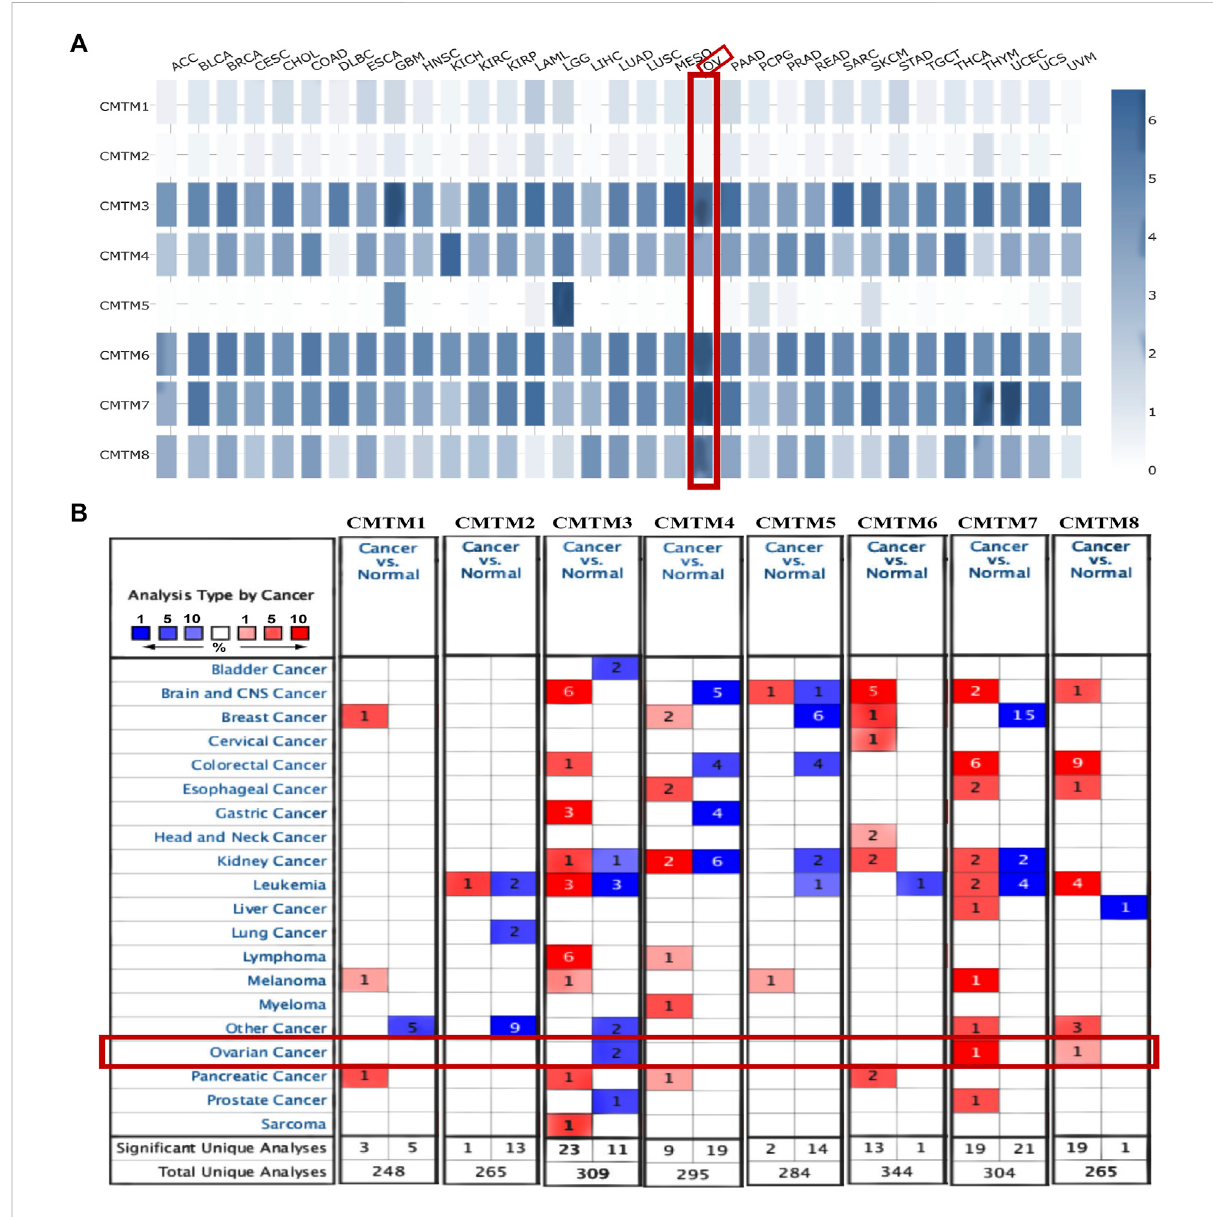
cancer was speci fi cally selected with a red line frame. The expression level of CMTM3/4/6/7/8 was relatively high in ovarian cancer. (B) The mRNA levels ofeachmemberoftheCMTM familyindifferenttypes ofcancer and thenumberofrelatedstudies basedon